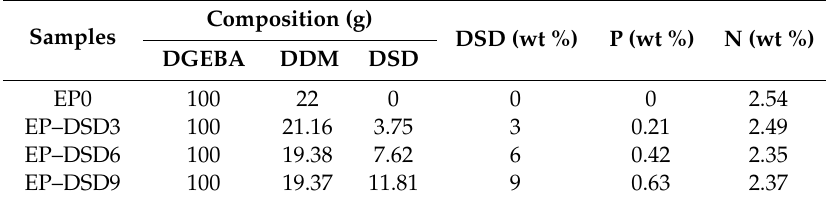
Table 1. The formulas of EP–DSD